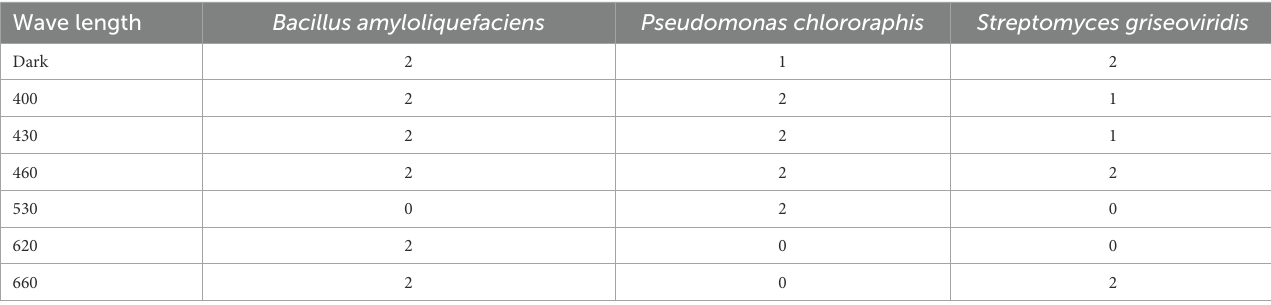
TABLE 1 Drop collapse of sole capric acid suspensions incubated with Bacillus amyloliquefaciens, Pseudomonas chlororaphis , or Streptomyces griseoviridis for 96 h under exposure to different light regimes (monochromatic LED at 400, 430, 460, 530, 620, and 660 nm; dark conditions). Wave length Bacillus amyloliquefaciens Pseudomonas chlororaphis Streptomyces griseoviridis